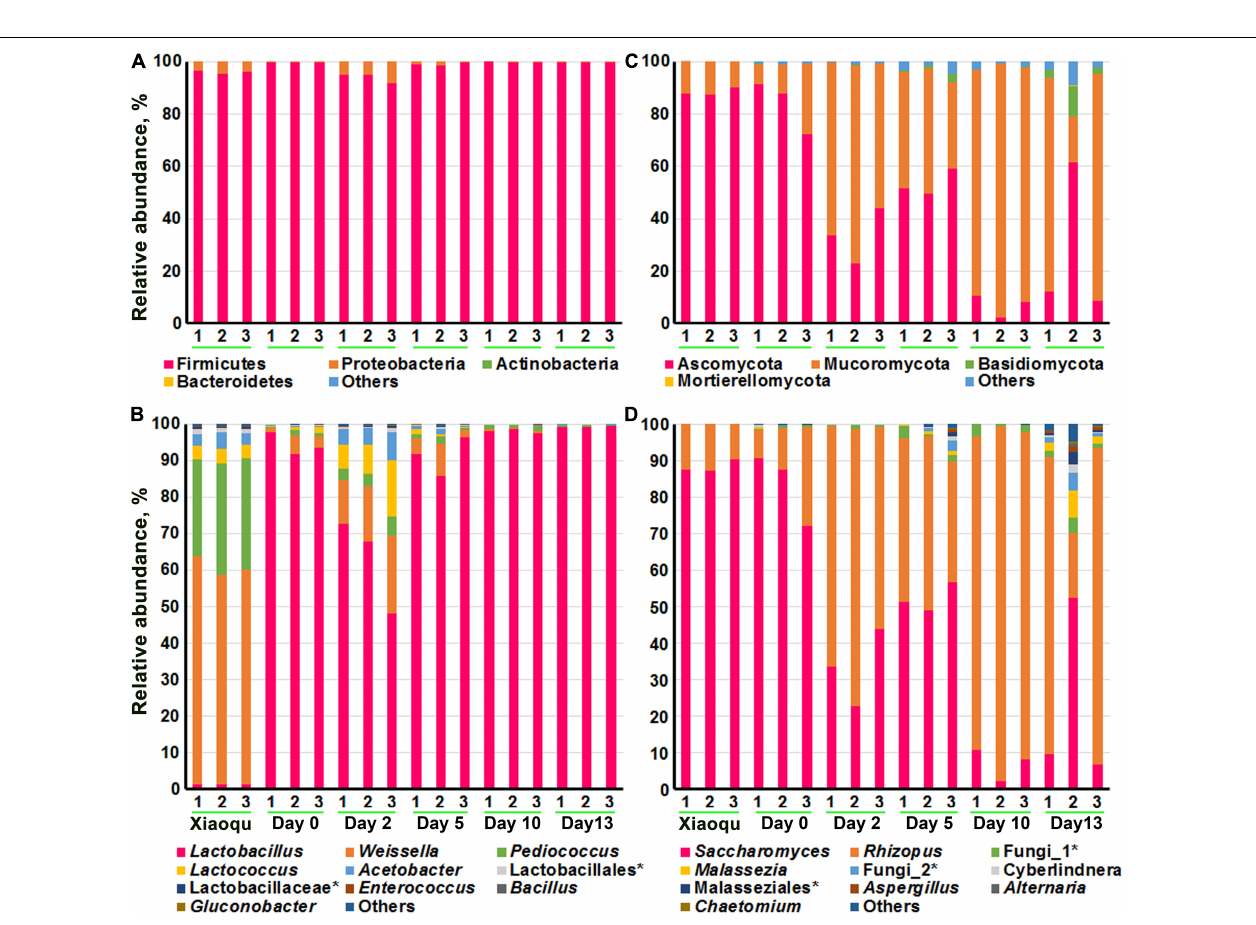
FIGURE 3 | The composition of microbial community in fermented rice in the production of rice-flavor baijiu. Bacteria at phylum (A) , and genus (B) levels. Fungi at phylum (C) , and genus (D) levels. 1, 2, and 3 represent three repeats. The rank in genera (top 10) was obtained according to the average relative abundance of all